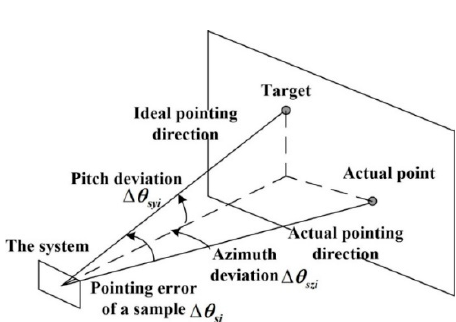
Figure 4. Meaning of pointing error of a sample △ (cid:2016) (cid:3046)(cid:3036)